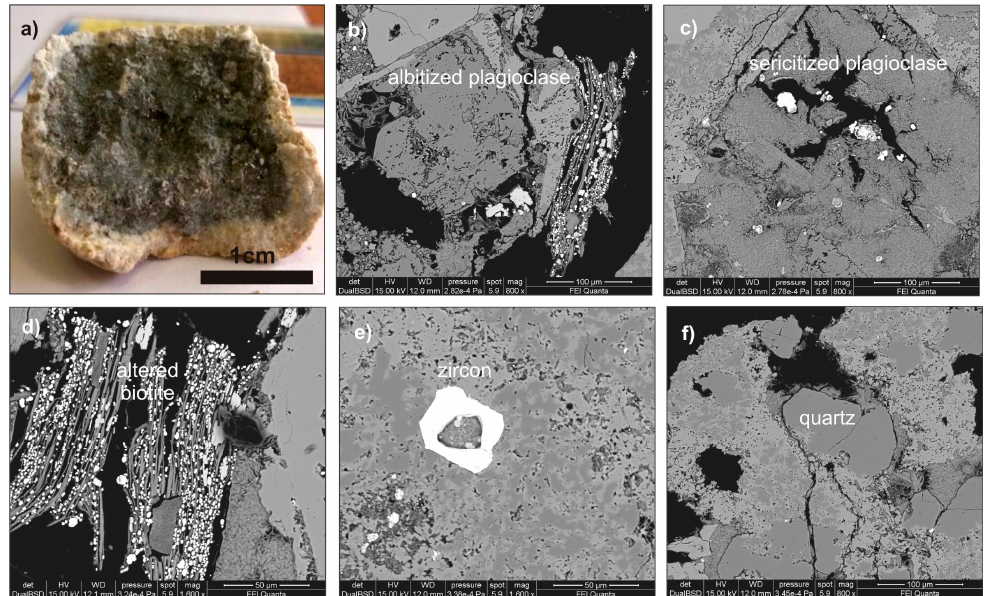
Figure 6. Hand specimen ( a ) and BSE images ( b – f ) of ST9BNR2C, quartz-K-feldspar altered rhyolite. Hydrothermal albite ( b ) partially replaced by phyllosilicates ( c ). Destroyed primary biotite with formation of hydrothermal phyllosilicates and rutile ( d ). Zircon in authigenic quartz-K-feldspar groundmass ( e ) with silicified zones ( f ).